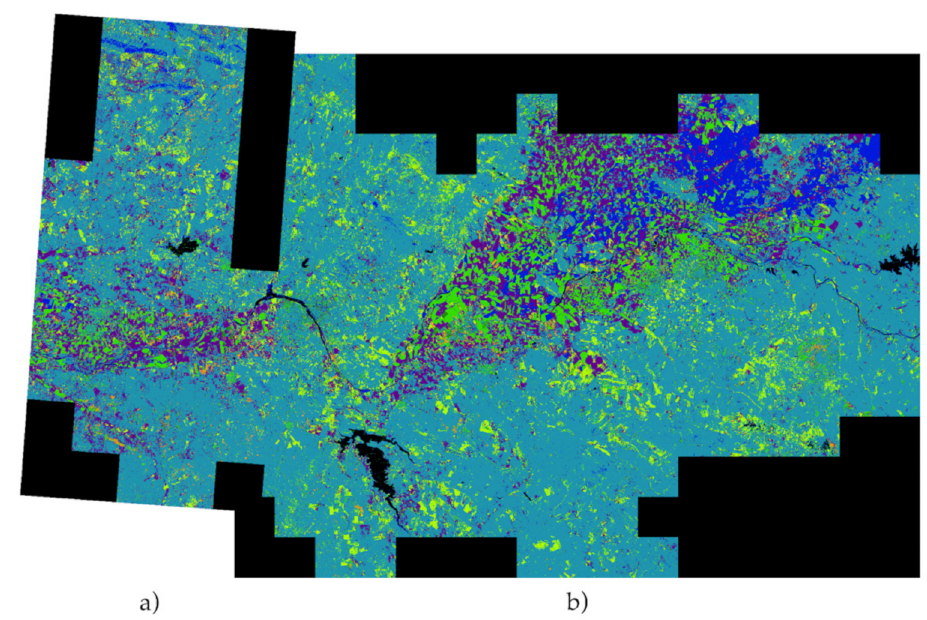
Figure 19. Predicted over all pixels mask of Zone 29 ( a ) and 30 ( b ). M é rida and Don Benito,